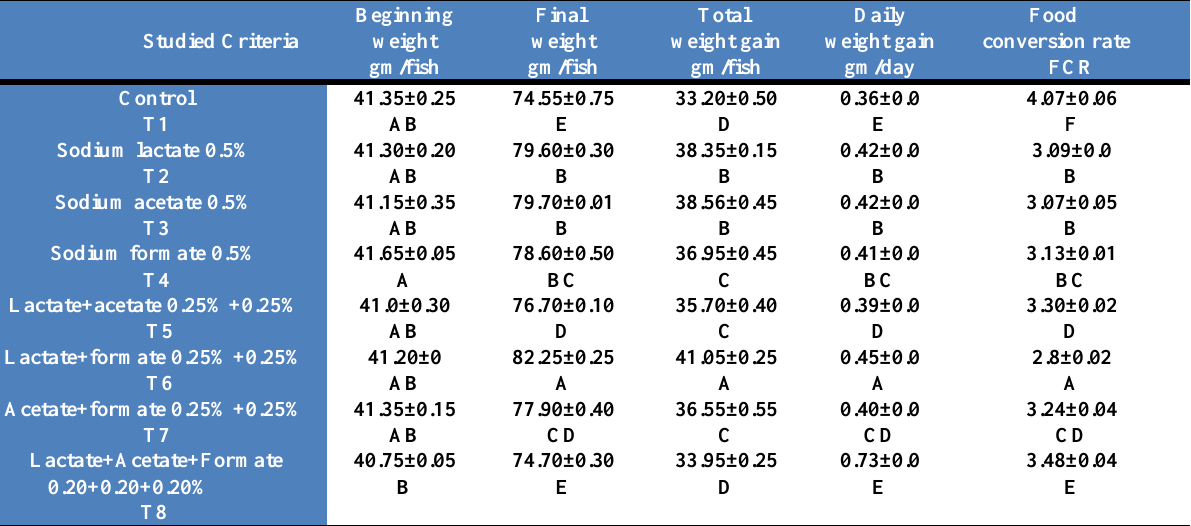
Table, 3: Rates of growth and feed conversion for Cyprinus carpio fish feed diets contain organic acids salts during 90